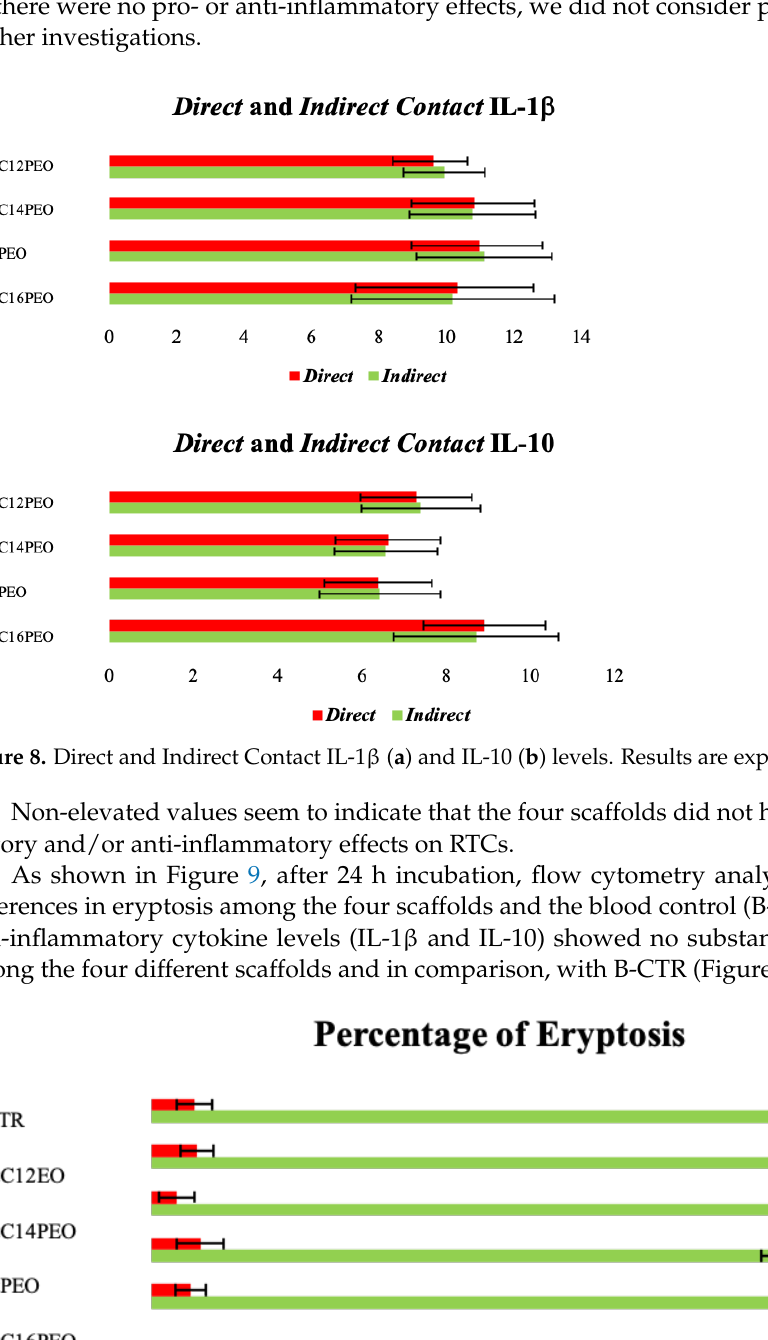
Figure 7. Percentage of Direct Contact ( a ) and Indirect Contact ( b ) viability, apoptosis and necrosis be- tween RTCs in CTR-Sol incubated 24 h with the 4 test devices and RTCs incubated only with CTR-Sol.